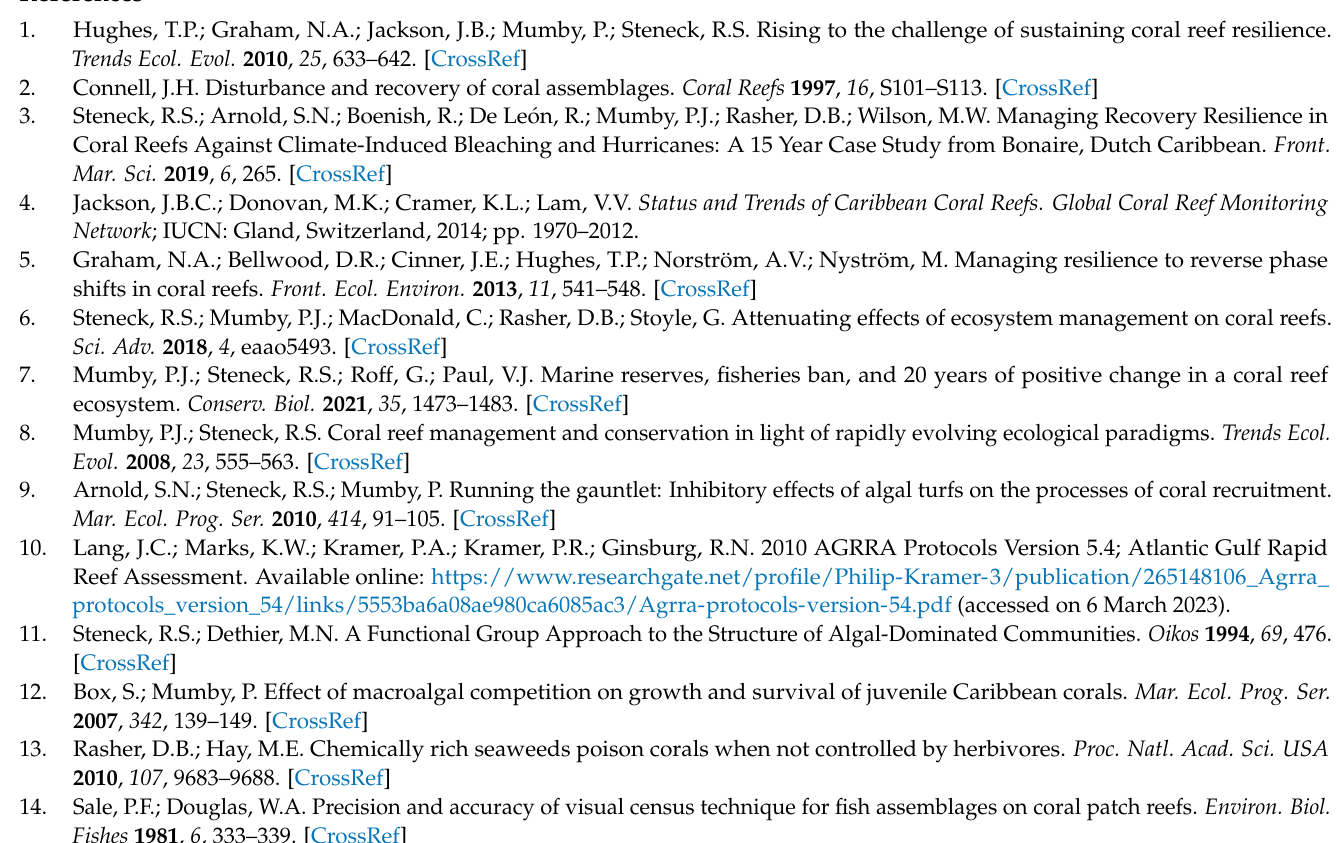
Table S1: Photographs from Montecristi region showing the effects of coral bleaching (2016) and hurricanes (September